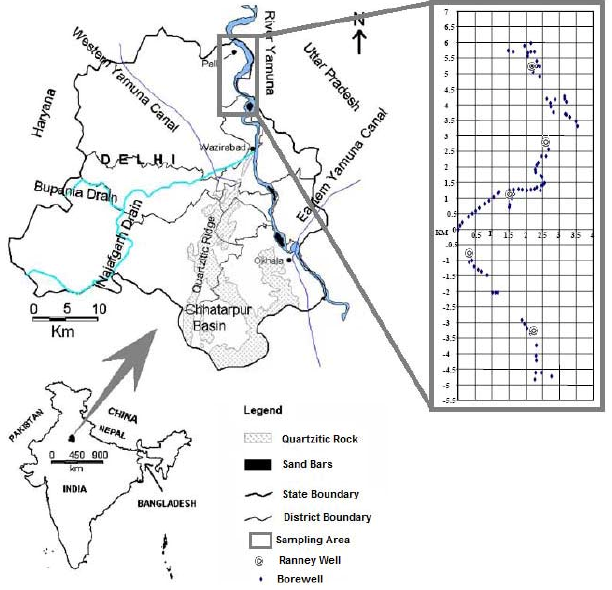
Figure 1. Map showing location of the study area (NCT Delhi) with the grids selected for the OCP analysis (map : modified from Shekhar and Prasad, 2009